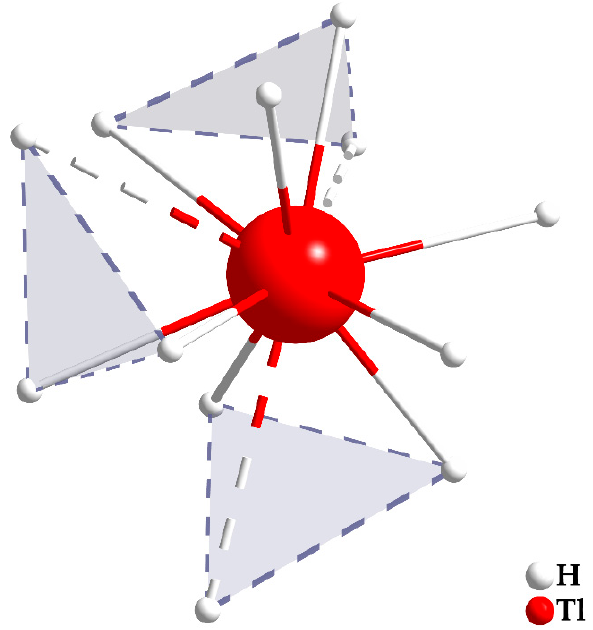
Figure 4. Reduced coordination scheme of the Tl + cation by hydrogen in the crystal structure of Tl[CB 11 H 12 ] confined to the first coordination sphere of atoms with triangular planes to indicate the coordination of the monocarbaborate cages [CB 11 H 12 ] − via edges or faces.